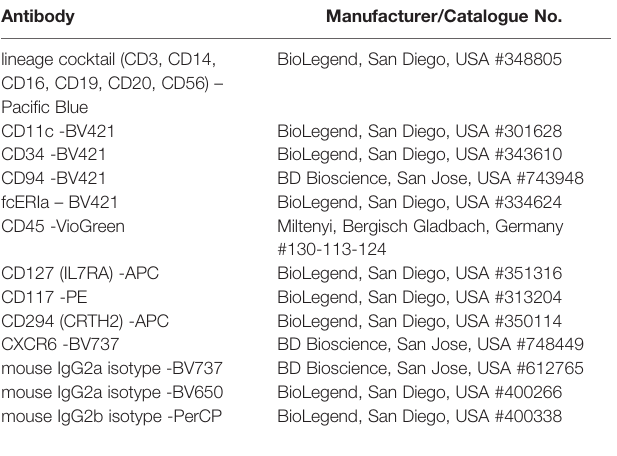
TABLE 3 | Antibodies used for fl ow cytometry immuno fl uorescence for ILC